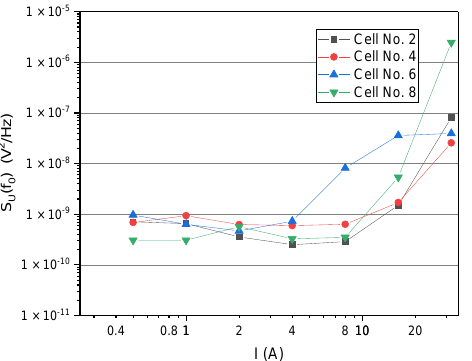
Figure 7. Power spectral density S u (f 0 ) of voltage fluctuations recorded between the terminals of the cell at the given frequency f 0 = 1 Hz versus loading current I.